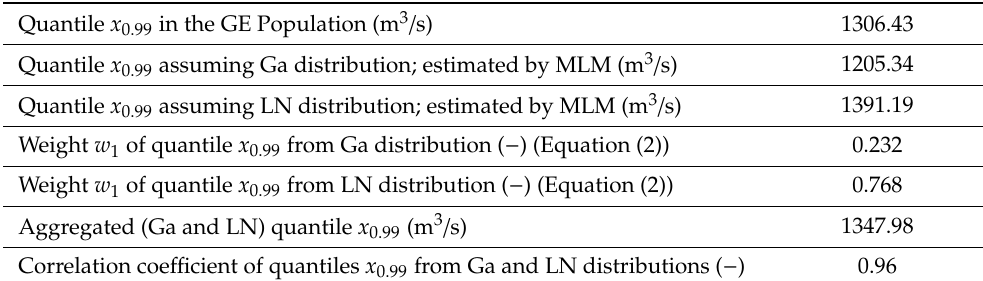
Table 2. Results of quantiles estimation in the simulation experiment (sample of 1000 elements). Quantile x 0.99 in the GE Population (m 3 /